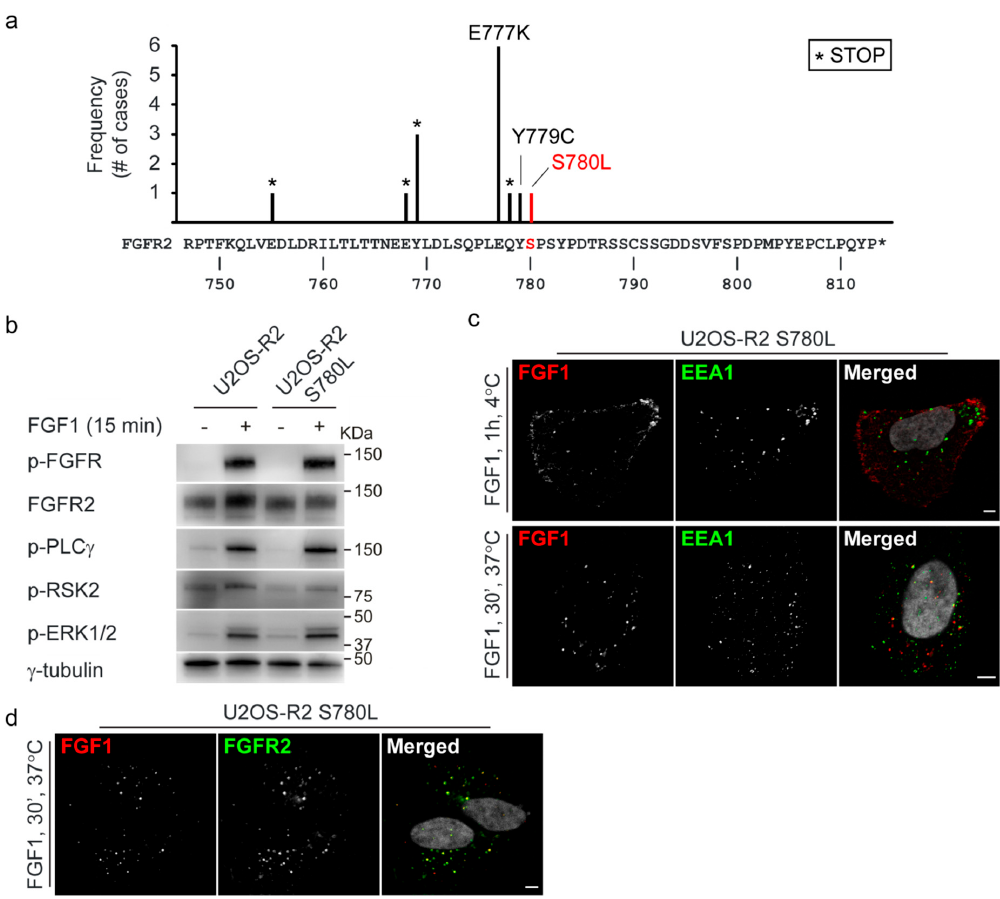
Figure 5. FGFR2 S780 is mutated in cancer. ( a ) The sequence of the C ‐ terminal tail of FGFR2. Variations that might influence S780 phosphorylation and have been identified in cancer patients are indicated. An asterisk indicates a stop codon. Numbers refer to the amino acid numbering used for human FGFR2 (NCBI: NM_000141). The variations are reported in cBioPortal and COSMIC. (b) U2OS ‐ R2 cells or U2OS ‐ R2 S780L cells were kept in serum ‐ free media for two hours and then treated or not with 100 ng/mL FGF1 for 15 minutes in the presence of heparin (20 U/mL). After lysis, the cellular material was analyzed by immunoblotting using the indicated antibodies. A p in front of the name of the antibody indicates that it recognizes the phosphorylated form of the protein. One representative experiment is shown. ( c ) U2OS ‐ R2 S780L cells were kept at 4 °C with DL550 ‐ FGF1 for one hour. Next, the cells were either fixed directly (upper panel) or incubated for 30 minutes at 37 °C before fixation (lower panel). The cells were then stained with anti ‐ EEA1 antibodies and Hoechst and analyzed by confocal microscopy. Representative images are shown. Scale bar: 5 μ M. ( d ) U2OS ‐ R2 S780L cells were treated with 200 ng/mL DL550 ‐ FGF1 in the presence of heparin (50 U/mL) for 30 minutes. The cells were then fixed, stained with anti ‐ FGFR2 antibodies and Hoechst, and analyzed by confocal microscopy. Representative images are shown. Scale bar: 5 μ M.